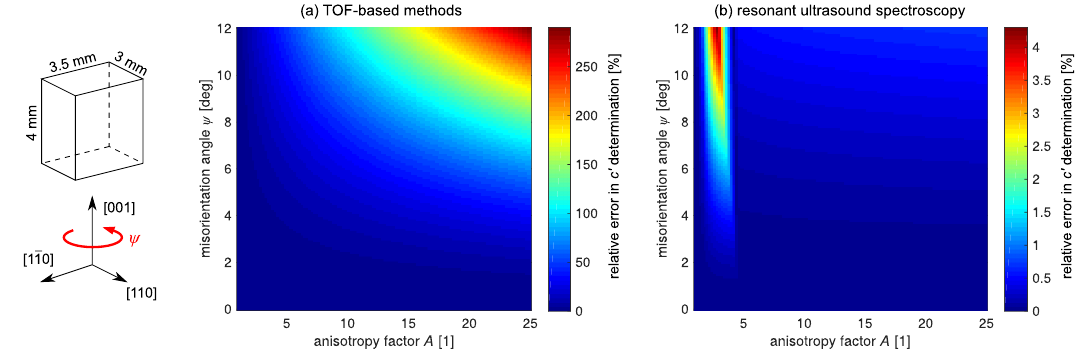
Figure 1. Simulated errors in c (cid:48) resulting from a small misorentation of the sample: ( a ) methods based on time-of-flight measurements; ( b ) resonant ultrasound spectroscopy. The misorientation angle ψ is defined in the sketch on the very